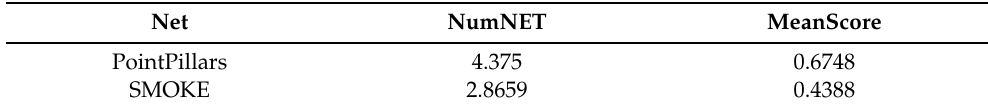
Table 2. The number of detected networks and the average object score of PointPillars and SMOKE after DE (3769 frames).